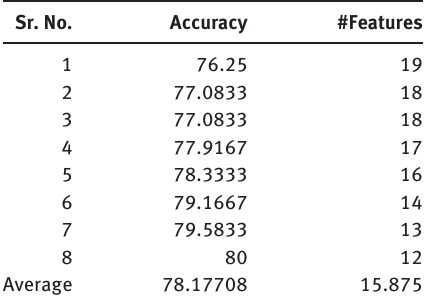
Table 2. Final Unique Non-dominated Solutions in Case of the German Data Set. Sr.